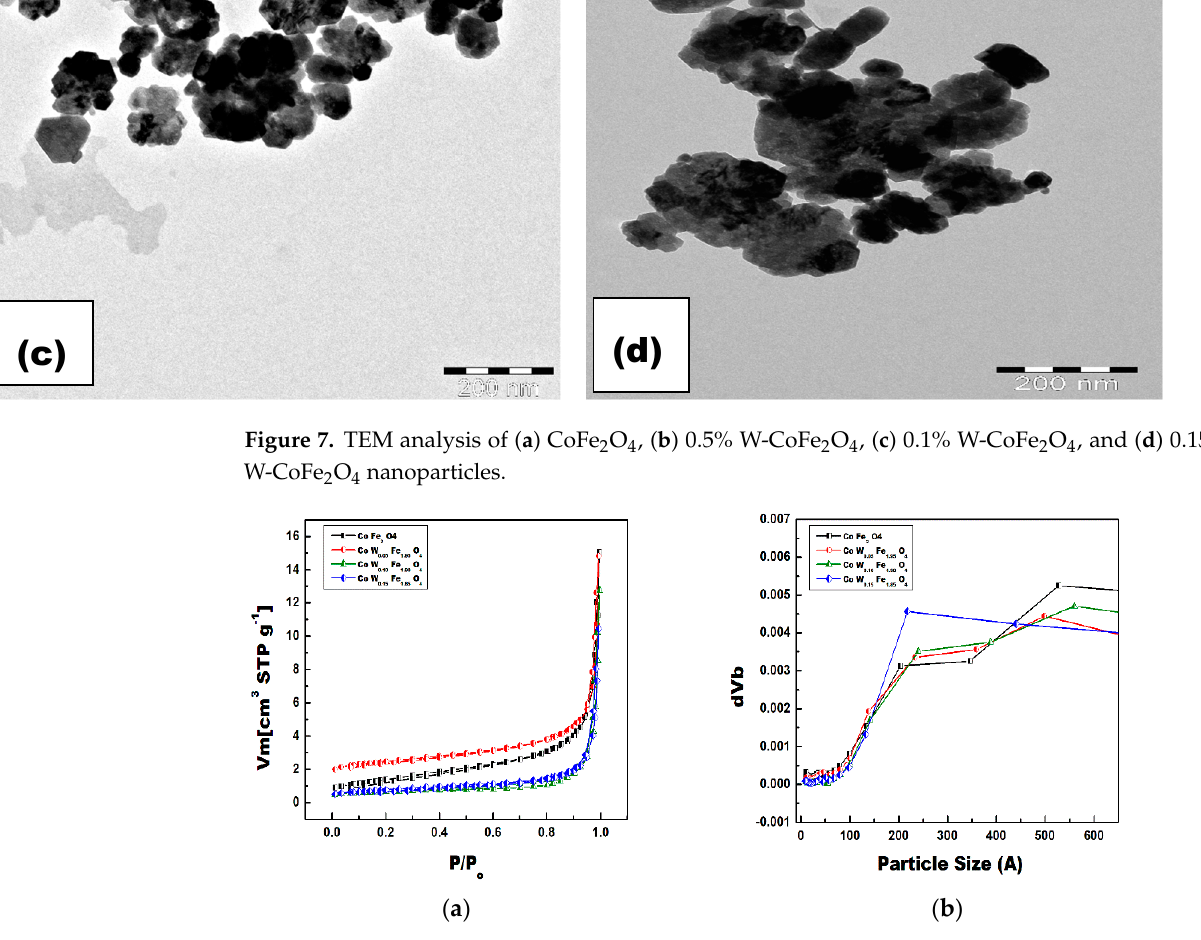
Figure 7. TEM analysis of ( a ) CoFe 2 O 4 , ( b ) 0.5% W-CoFe 2 O 4 , ( c ) 0.1% W-CoFe 2 O 4 , and ( d ) 0.15% W- CoFe 2 O 4 nanoparticles .